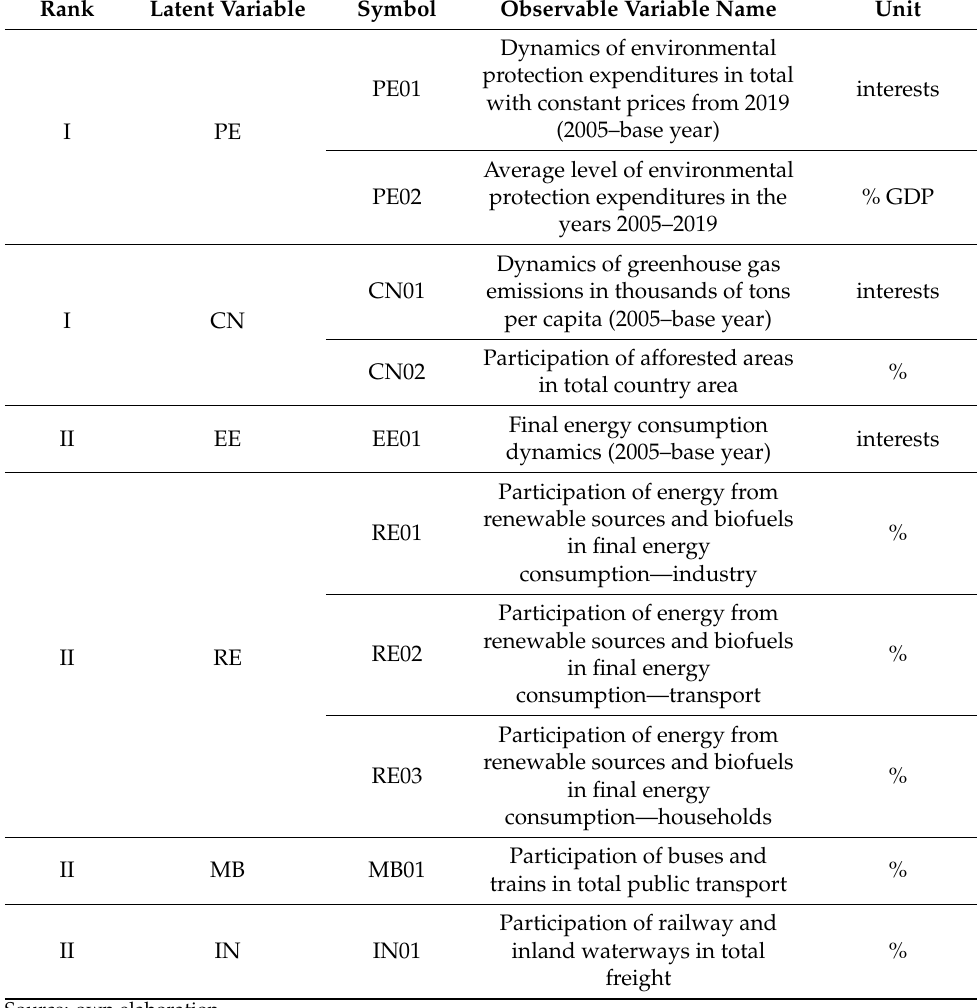
Table 1. List of latent variables rank I and II